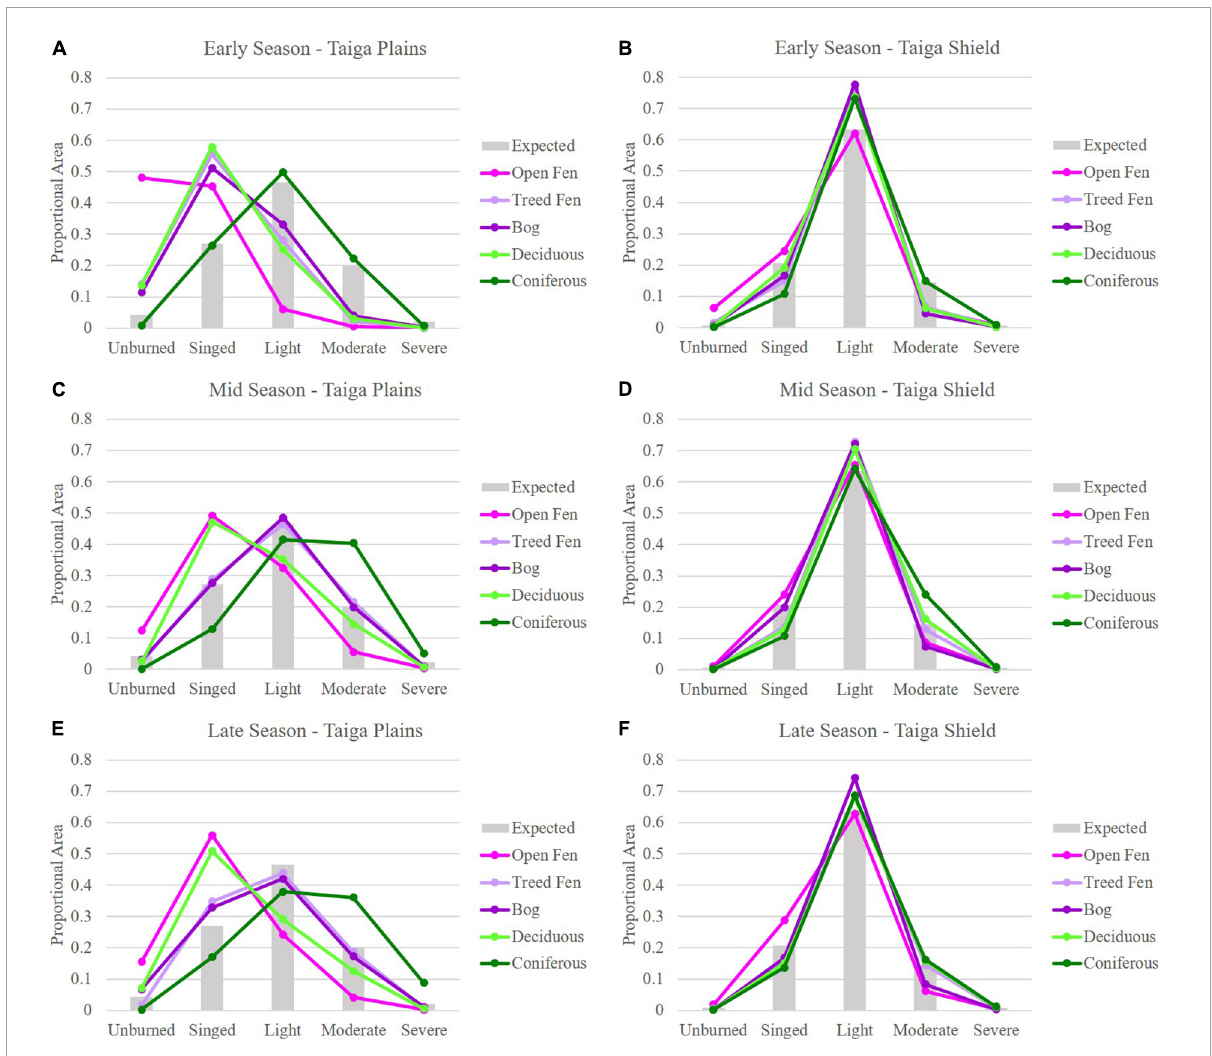
FIGURE12 Plots of expected (gray bars) and actual proportional area of each burn severity for each ecotype by (A) early season on the Taiga plains; (B) early season on the Taiga shield; (C) mid-season on the Taiga plains; (D) mid-season on the Taiga shield; (E) late season on the Taiga plains; and (F) late season on the Taiga